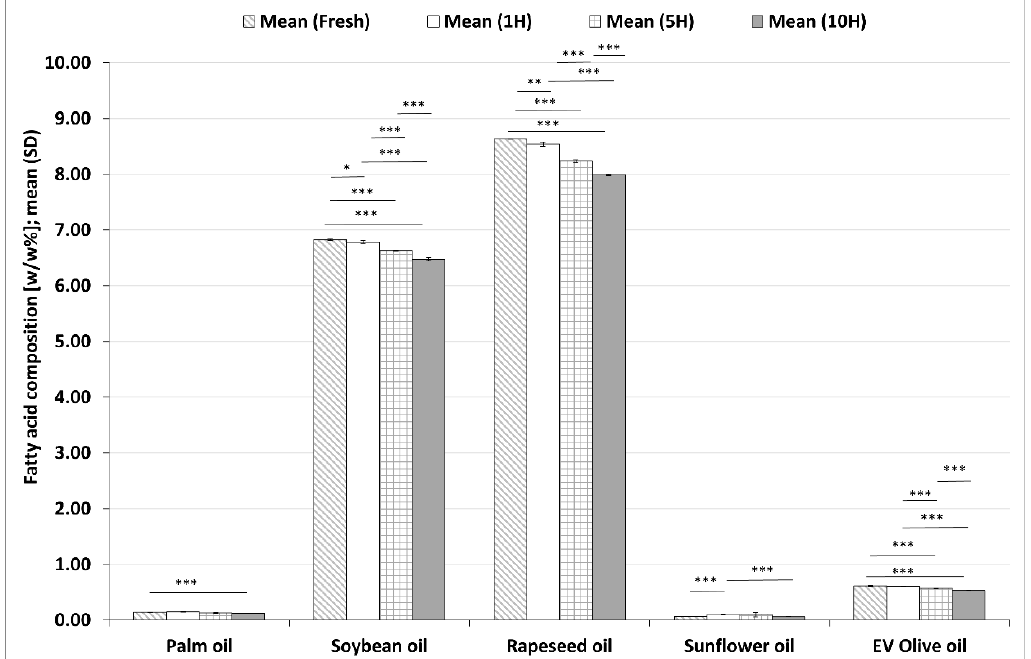
Figure 3. Changes in alpha-linolenic acid (ALA) values in five different plant-based oils in fresh samples and after one (1H), five (5H) and ten heating sequences (10H). Each column shows the mean (SD) data of six different chromatograms. Asterisks denote statistically significant differences between the different time points in the same oil; *: 0.01 ≤ p < 0.05; **: 0.001 ≤ p < 0.01; ***: p < 0.001. EV olive oil: extra virgin olive oil.